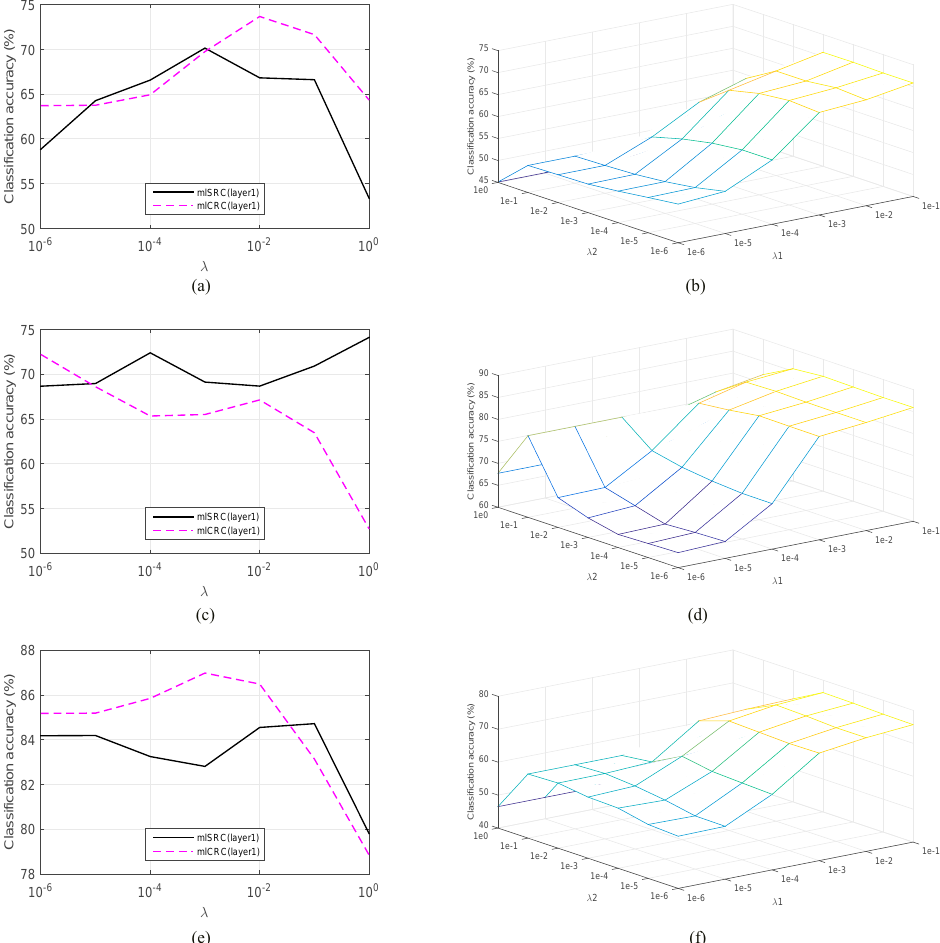
Figure 4. Overall classification accuracy (%) of representation-based classifiers versus λ using 40 training samples per class, ( a , b ) λ for mlSRC, mlCRC and multi-layer elastic net representation-based classification (mlENRC) at the first layer in the Indian Pines image; ( c , d ) λ for mlSRC, mlCRC and mlENRC at the first layer in the University of Pavia image; ( e , f ) λ for mlSRC, mlCRC and mlENRC at the first layer in the Salinas image.